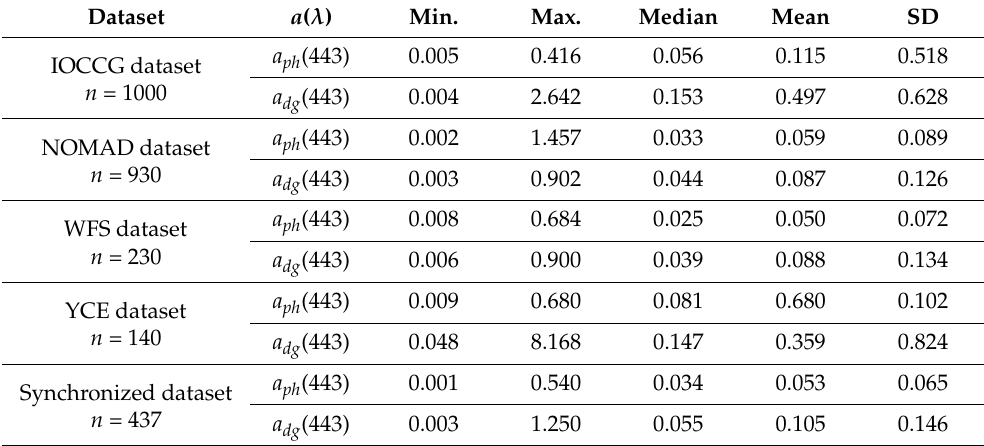
Table 1. A statistical summary of observed a( λ ) for the NOMAD, YCE, WFS, IOCCG, and Bohai